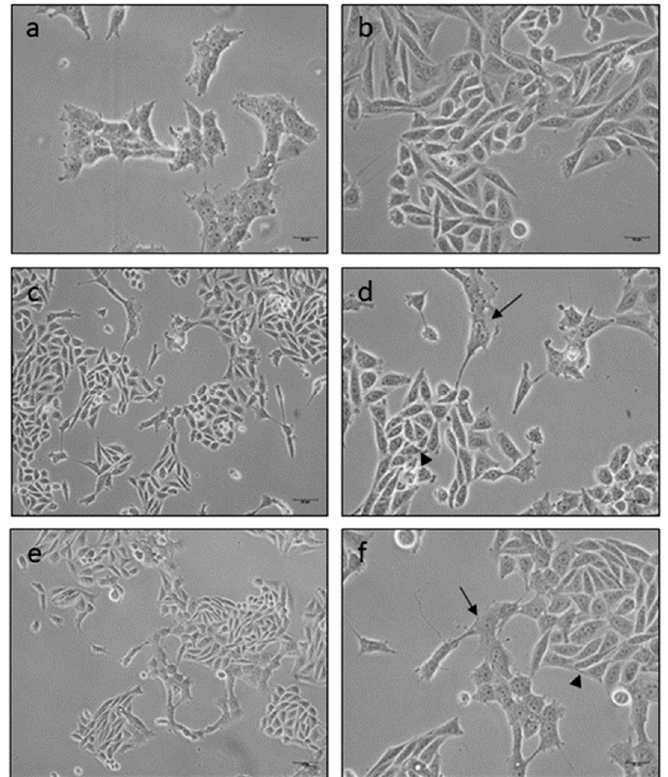
Figure 4. Representative phase contrast inverted microscopy images showing SH-SY5Y (arrowheads) and HOG cells (arrows) grown in a direct physical contact after 48 ( c , d ) or 72 h ( e , f ) of mixed culture. Cell processes were longer than those in the HOG ( a ) and SH-SY5Y ( b ) cells grown separately during 72 h. ( a , b , d , f ) Scale bars 10 μ m (20×); ( c , e ) Scale bars 10 μ m (10×).